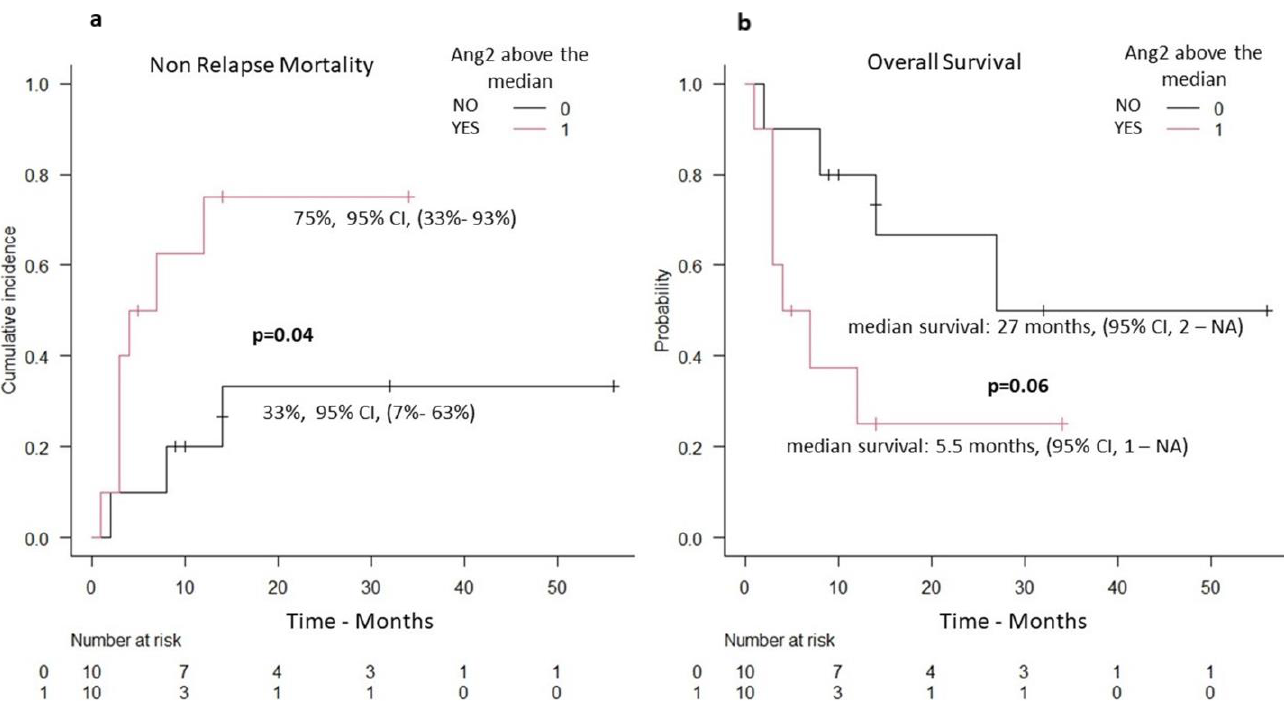
Figure 4. Patients with TMA and serum Ang2 levels (n = 20 patients): ( a ) non-relapse mortality (increased NRM in the group of patients with serum Ang2 above the median), ( b ) overall survival (decreased OS in the group of patients with serum Ang2 above the median).